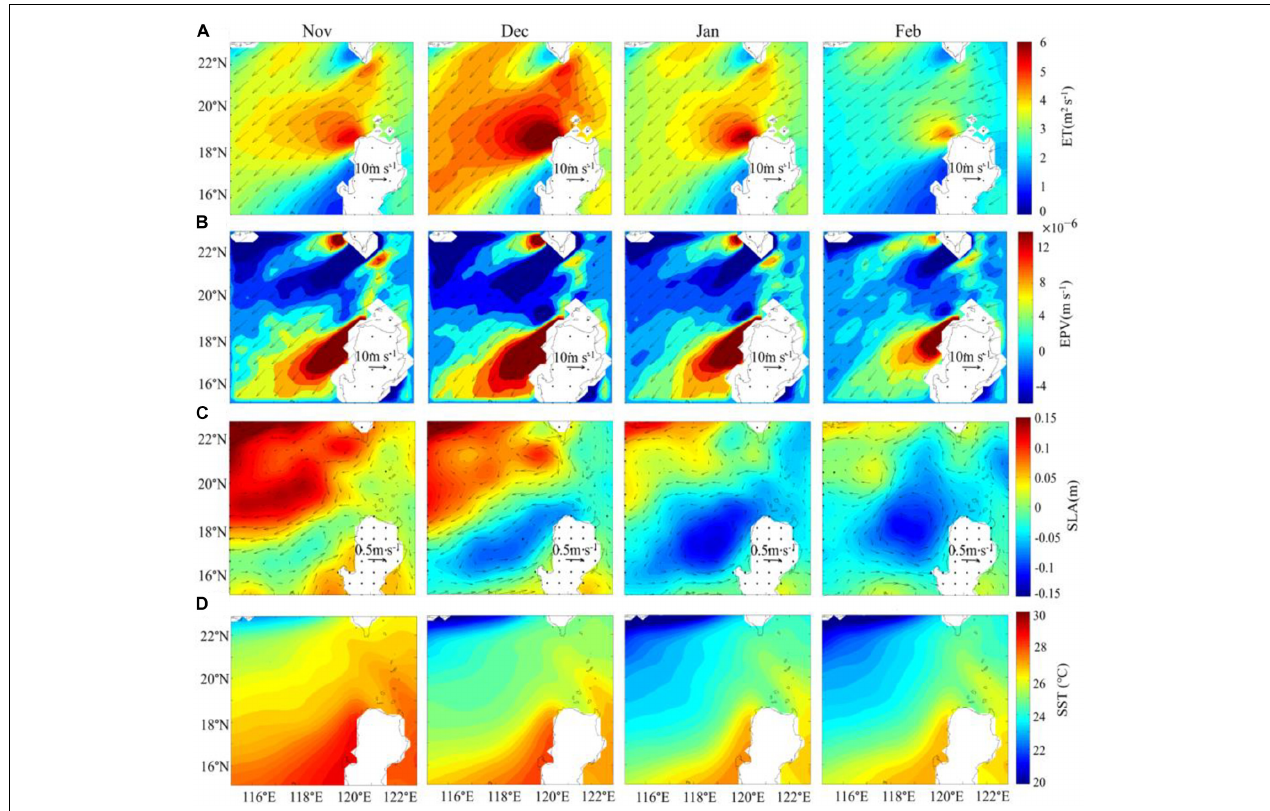
FIGURE 5 | Monthly mean (A) Ekman Transport (ET), and (B) Ekman Pumping velocity (EPV) derived from Sea surface wind speed (WS) products of the QuikSCAT and ASCAT, (C) Sea Level Anomalies (SLA) from AVISO, (D) Sea Surface Temperature (SST) from AVHRR with a spatial resolution of 0.25 ◦ in winter. The arrows in (A,B) indicate the direction and size of wind speed. The arrows in (C) indicates the direction and size of the geostrophic